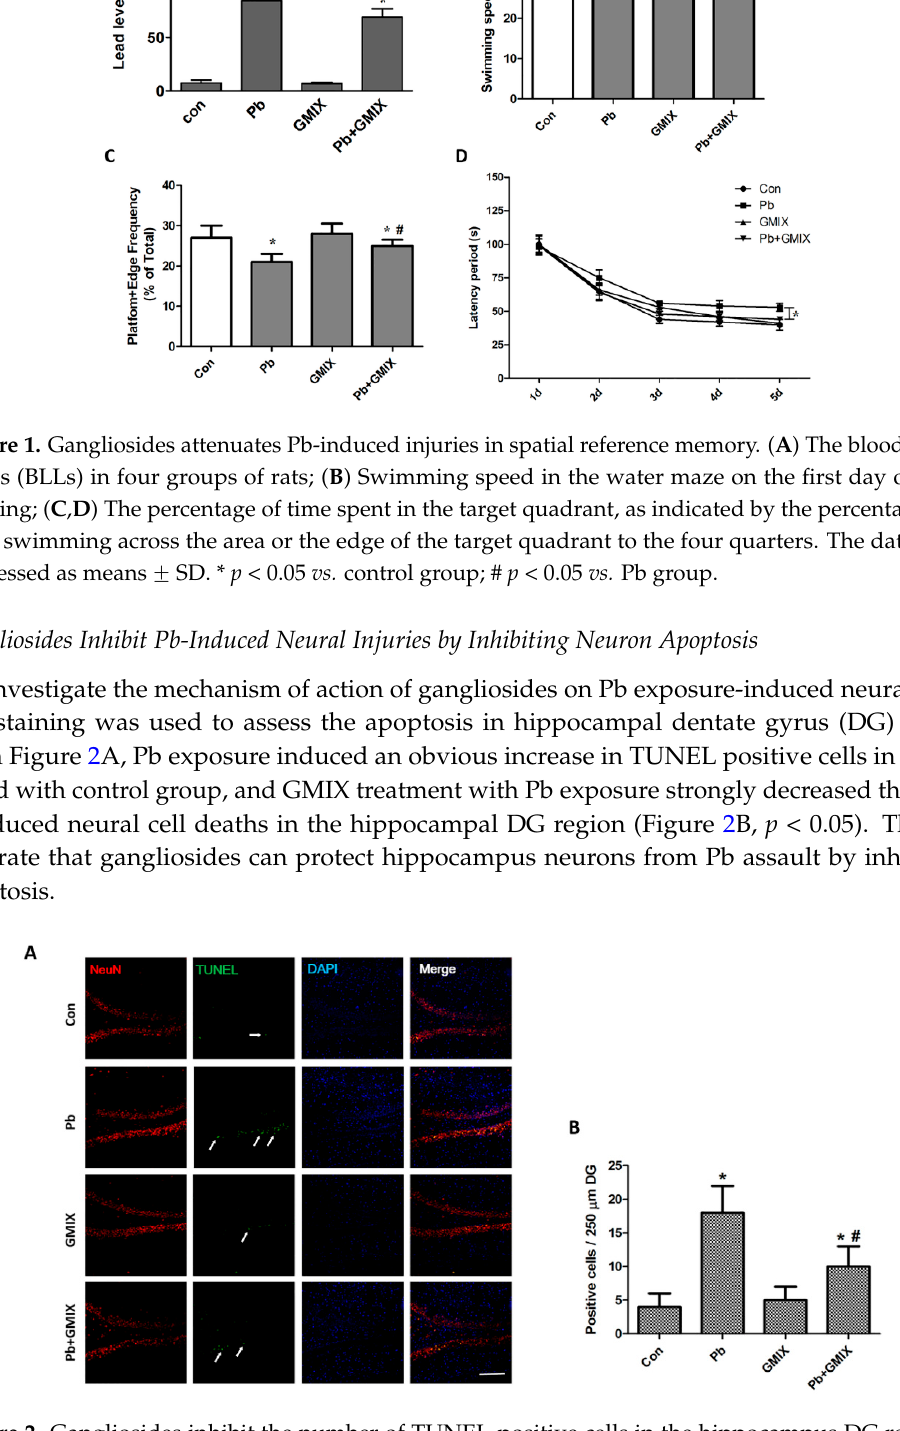
Figure 2. Gangliosides inhibit the number of TUNEL-positive cells in the hippocampus DG region. ( A ) Cell apoptosis is detected by in situ NeuN (red), TUNEL (green) and DAPI (blue), and the arrows represent TUNEL positive cells; ( B ) Quantification is performed by counting the number of surviving neurons and apoptotic-like neurons per 250 μ m length in the medial DG pyramidal cell layer. The results are expressed as the mean ± SD ( n = 4, scale bar = 50 μ m). * p < 0.05 vs. control group; # p < 0.05 vs. Pb group.